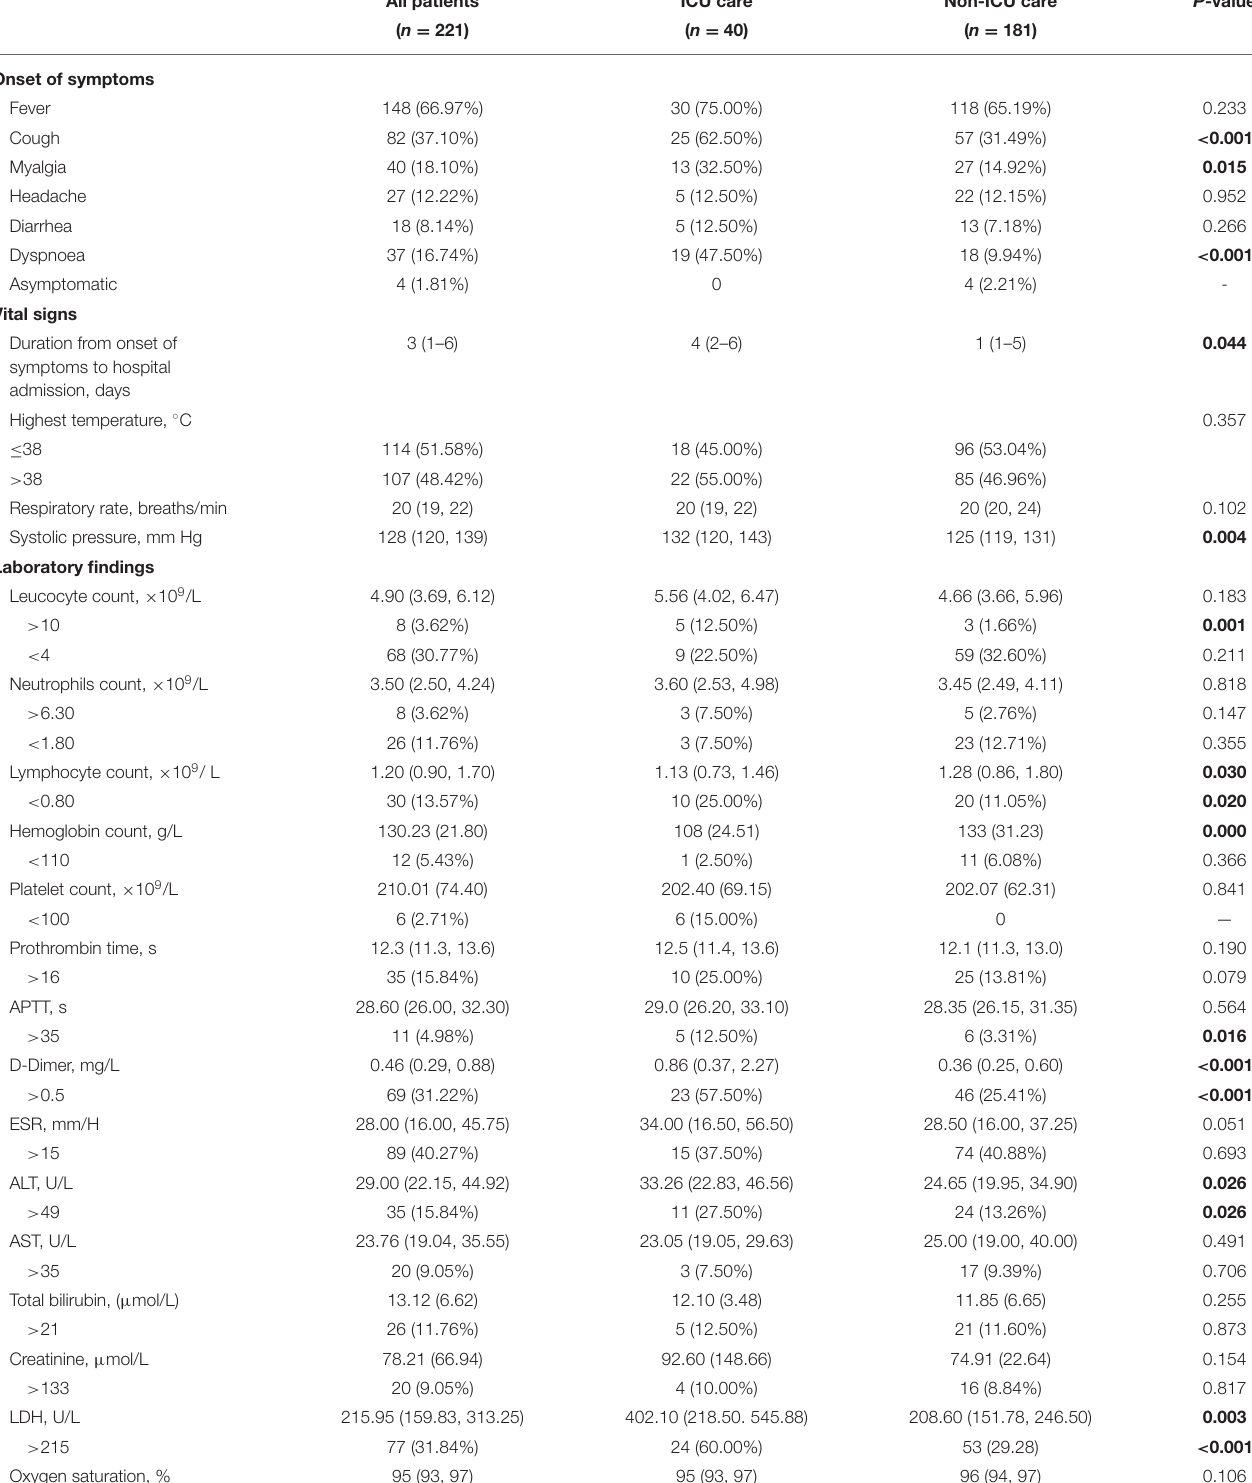
TABLE 2 | Onset of symptoms, vital signs, and laboratory findings in patients with COVID-19 pneumonia. All patients ICU care Non-ICU care P